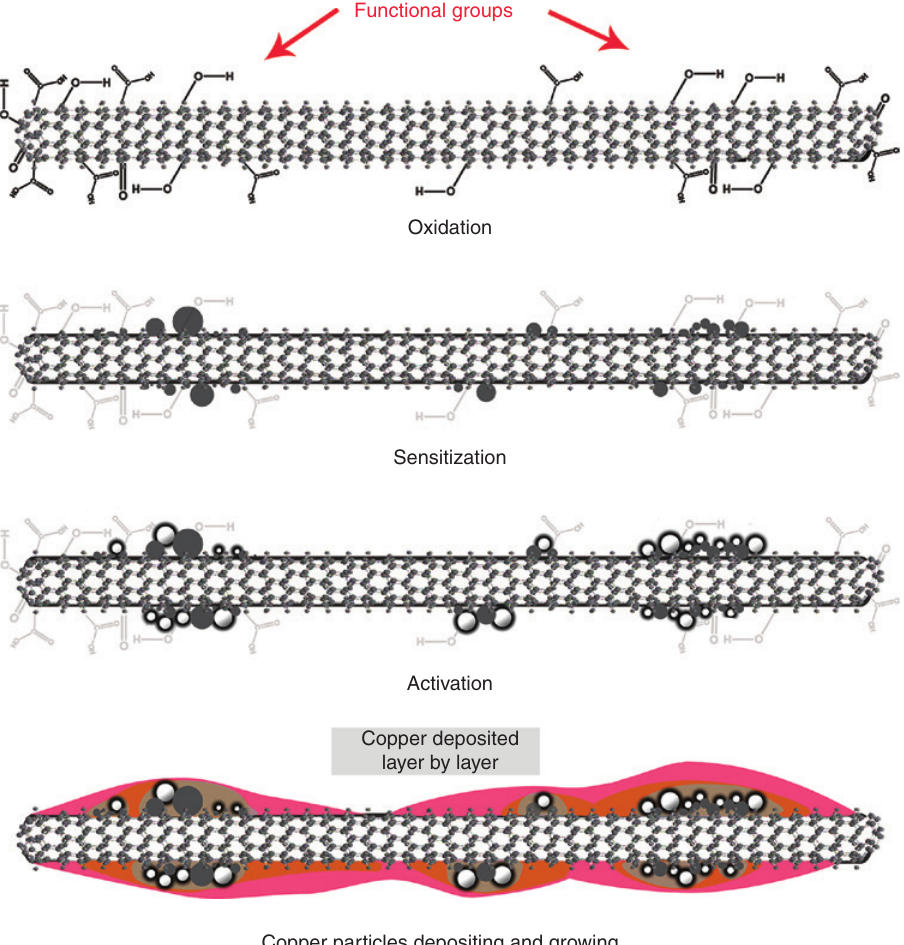
Figure 1: Schematic fabrication process steps of the copper electroless